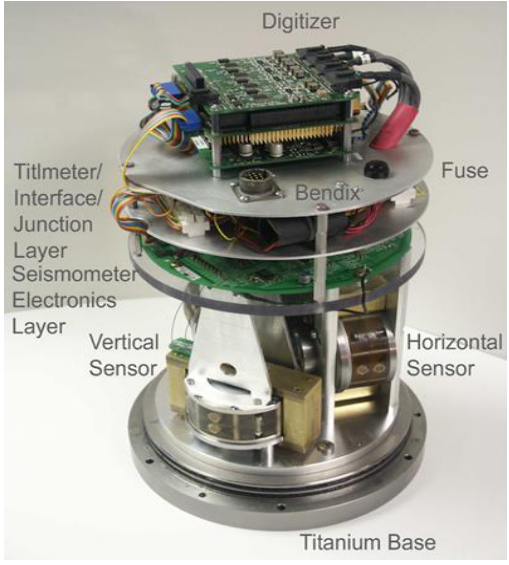
Figure 5. An assembled 3-axis linear MET seismometer including two orthogonal horizontal sensors and one vertical sensor, along with the sensing circuits.